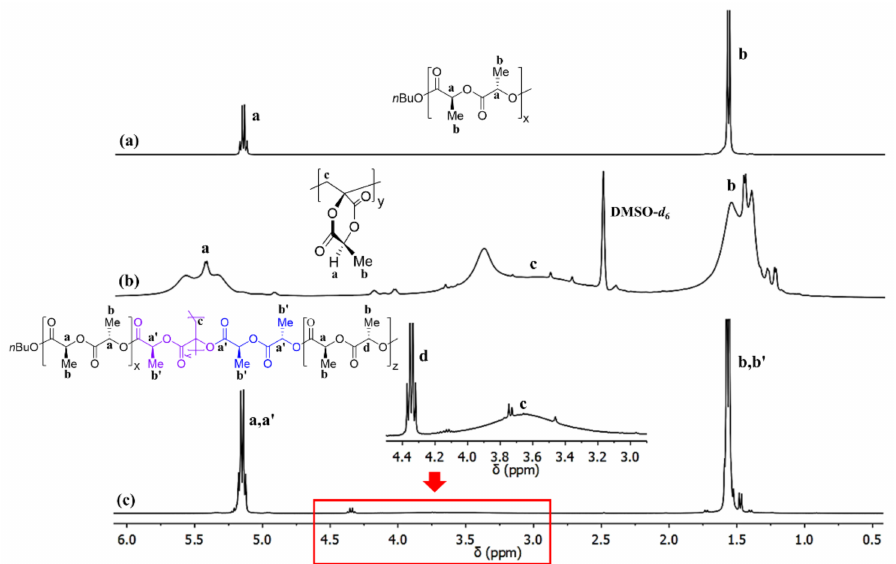
Figure 4. 1 H-NMR spectra of homopolymers and graft copolymers: ( a ) PLA (400 MHz, CHCl 3 - d 1 );